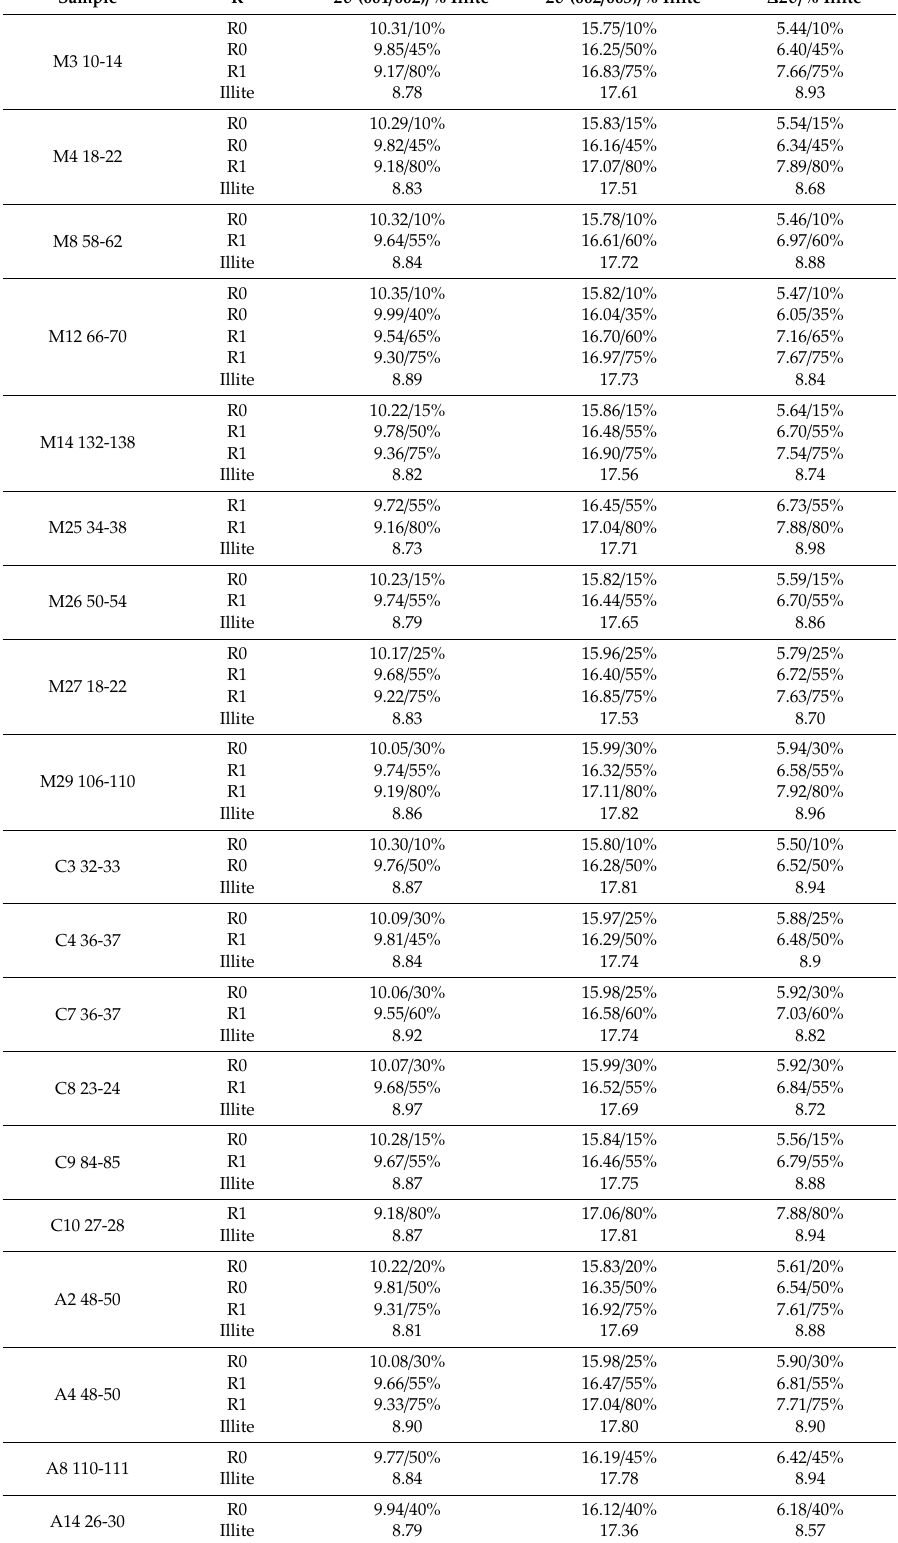
Table 2. I-S peaks characteristic of the deconvoluted XRD patterns. Illite proportions were calculated following standard [64]